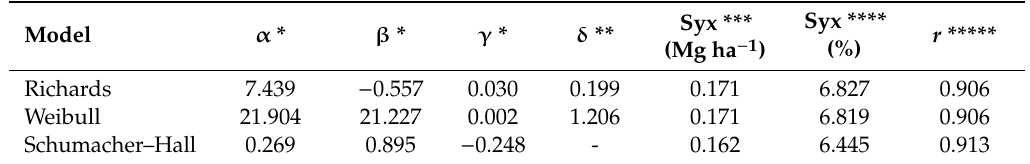
Table 9. Statistical parameters of the non-linear models obtained in the adjustment of the amount of calcium in the eucalypt